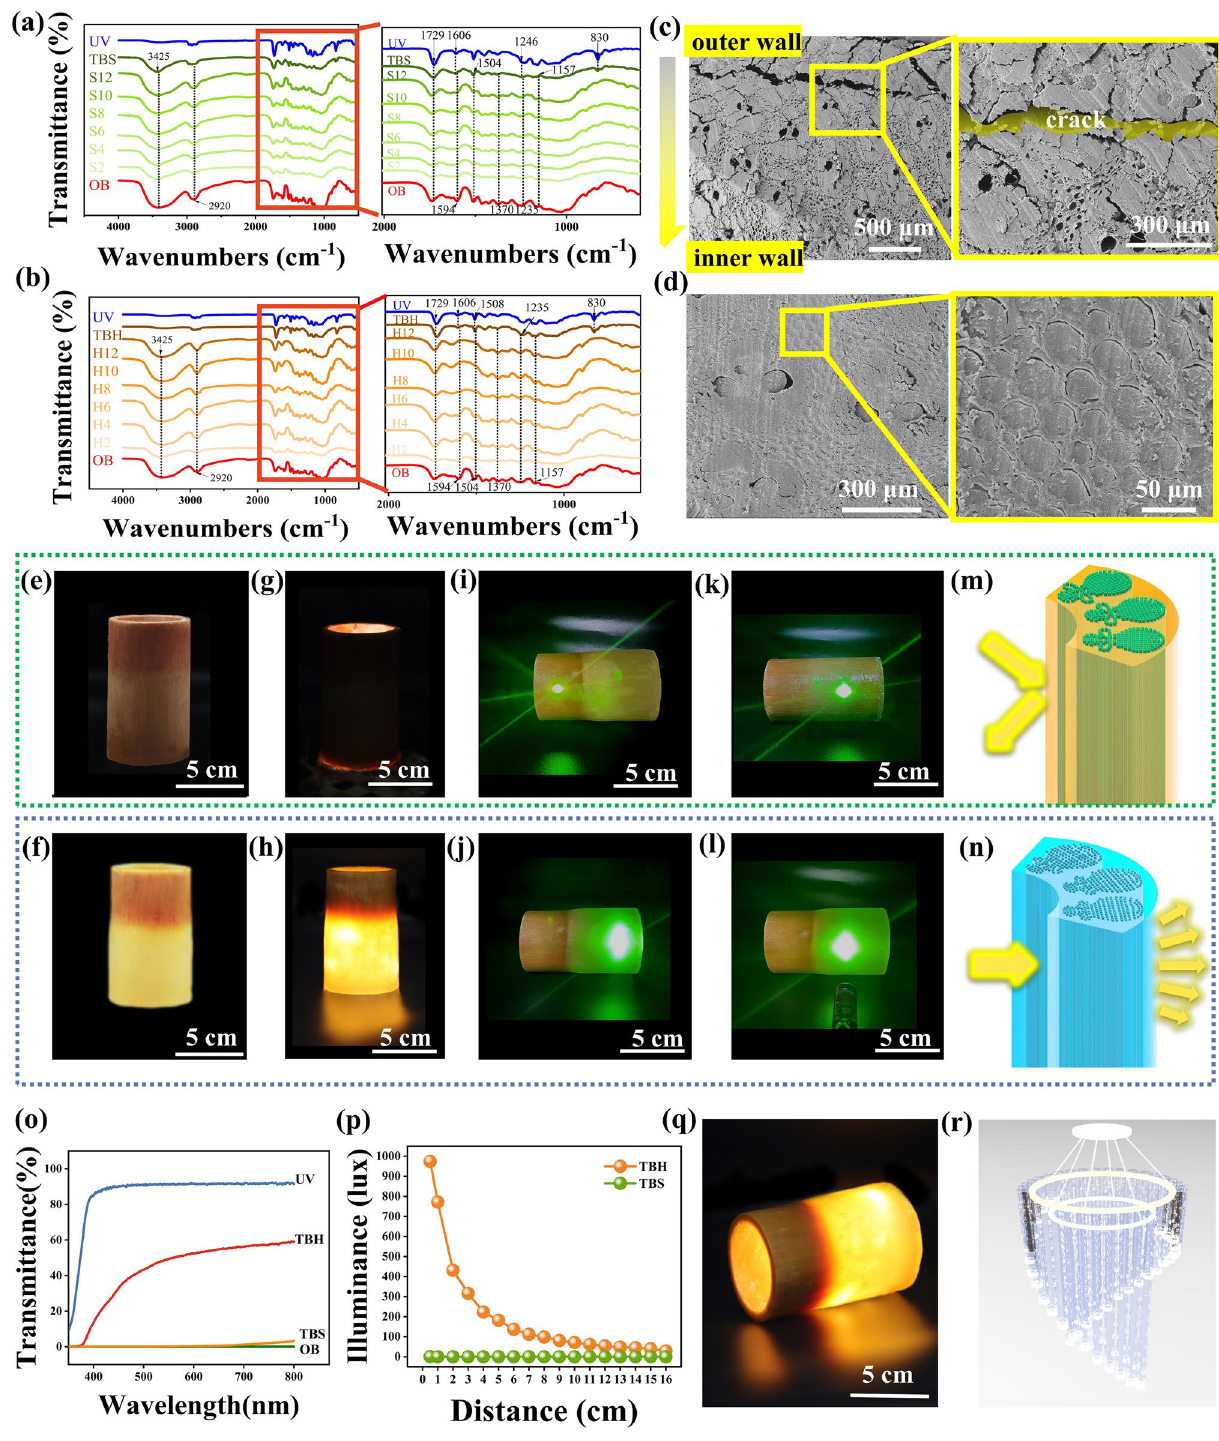
Fig. 4 a FTIR curves of OB, S2, S4, S6, S8, S10, S12, TBS, and UV resin. b FTIR curves of OB, H2, H4, H6, H8, H10, H12, TBH, and UV resin. c Cross- sectional SEM images of TBS. d Cross-sectional SEM images of TBH. e Digital image of TBS. f Digital image of TBH. g Digital image of TBS with LED lights installed. h Digital image of TBH with LED lights installed. i Laser irradiation of untreated bamboo. j Laser irradiation of TBH. k Laser irradiation of TBS. l Laser irradiation of TBH. m Schematic diagram of the reflection of the light beam on the surface of untreated bamboo. n Schematic diagram of the light beam passing through TBH. o Light transmission of OB, TBS, TBH, and UV resin. p Illumination change diagram of TBH and TBS. q Macroscopic view of TBH, r A rendering of a decorative lighting fixture designed by translucent whole